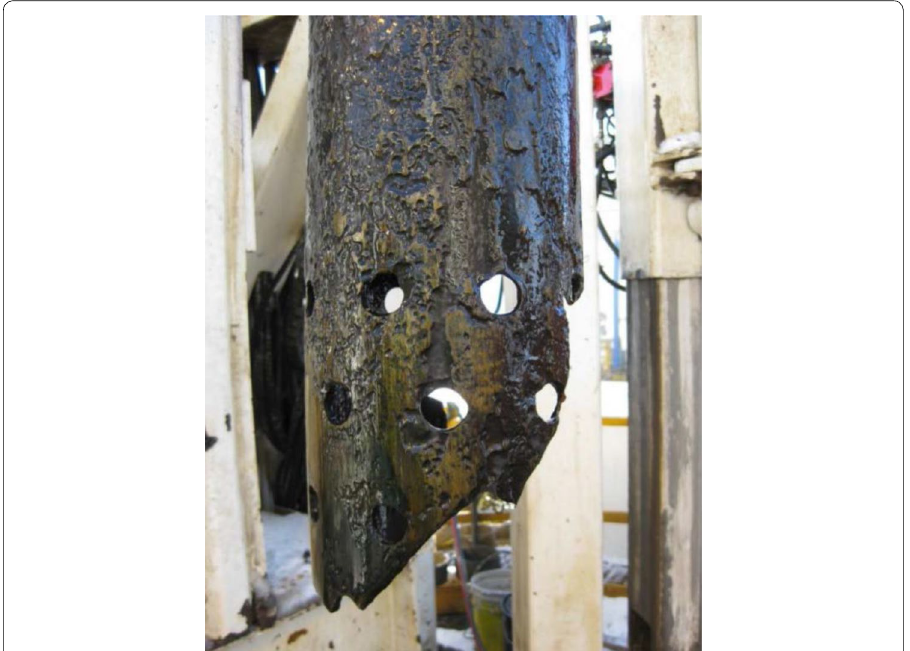
Fig. 3 Heavy corrosion of liner pipe in the KJ-39 well (source: deliverable D4.3 from GeoWell project, Thorbjornsson